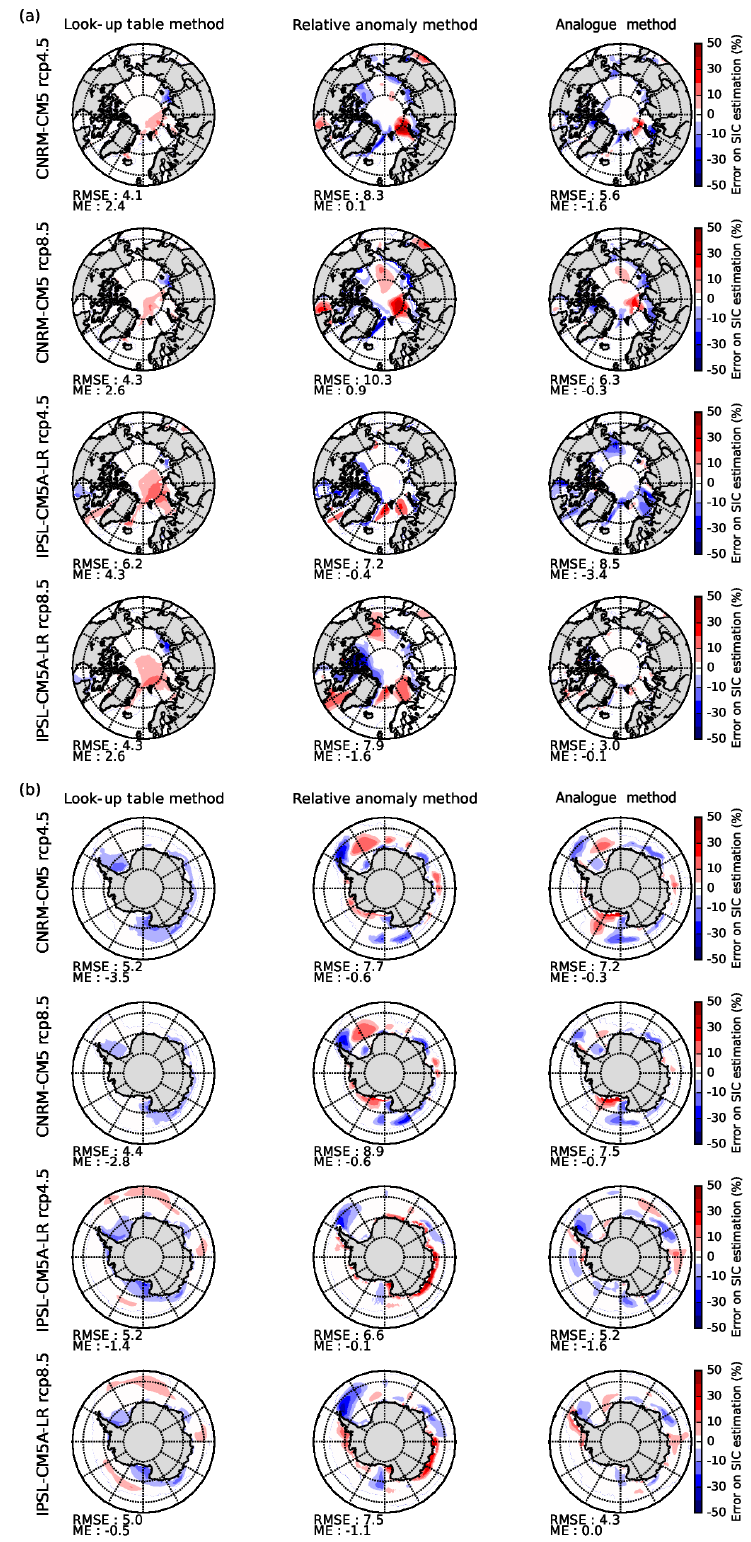
Figure 5. Mean error in the estimation of SIC with respect to the original AOGCM future scenario for the LUT, iterative relative anomaly and analogue methods with CNRM-CM5 and IPSL-CM5A-LR RCP4.5 and RCP8.5 scenarios for the Arctic (a) and the Antarctic (b)